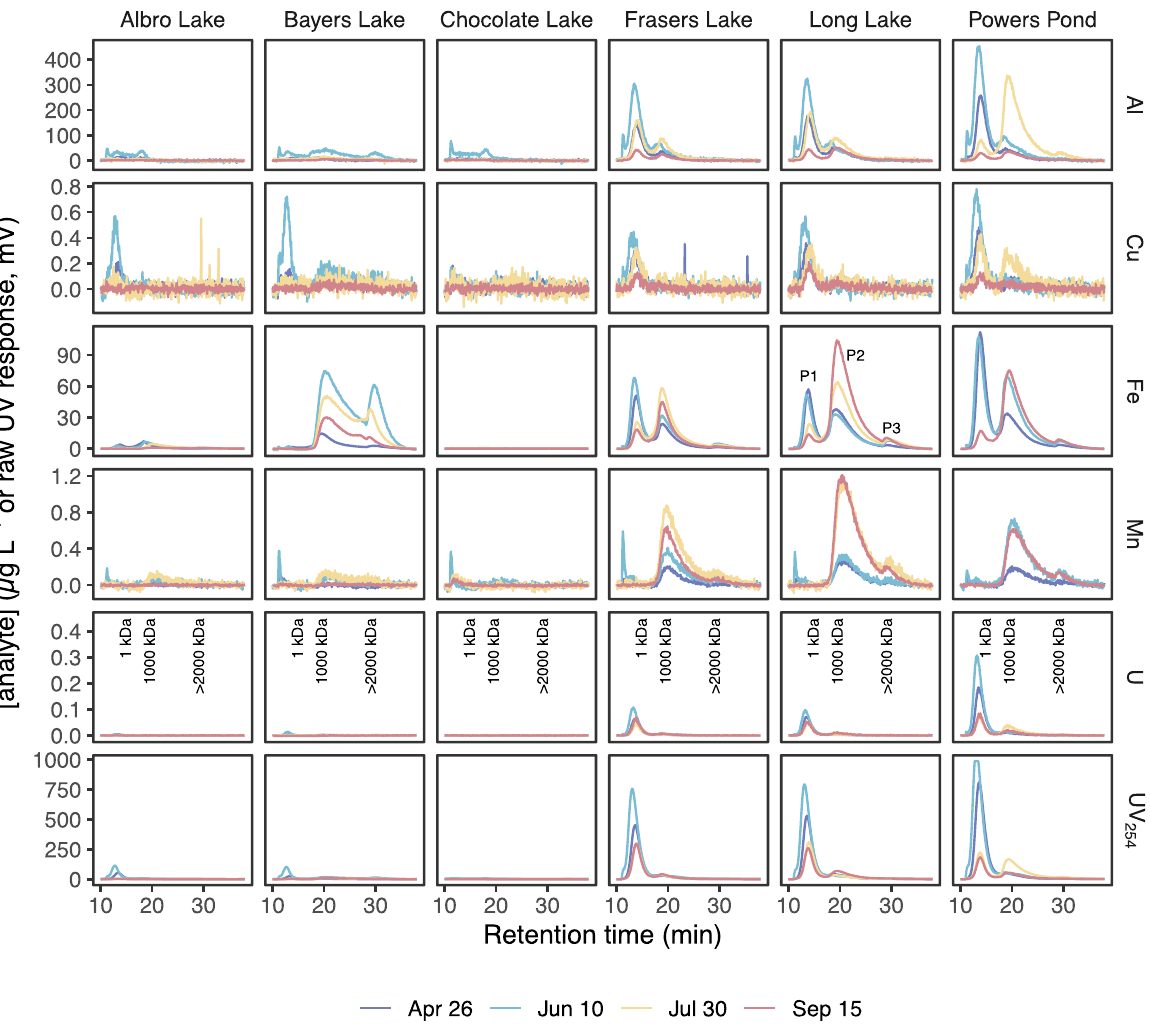
Fig. 3 Semiquantitative fractograms representing the six study lakes. The July Fe and Mn data representing Powers Pond are omitted for clarity of presentation due to anomalously high concentrations. Data were collected in 2019 (Table